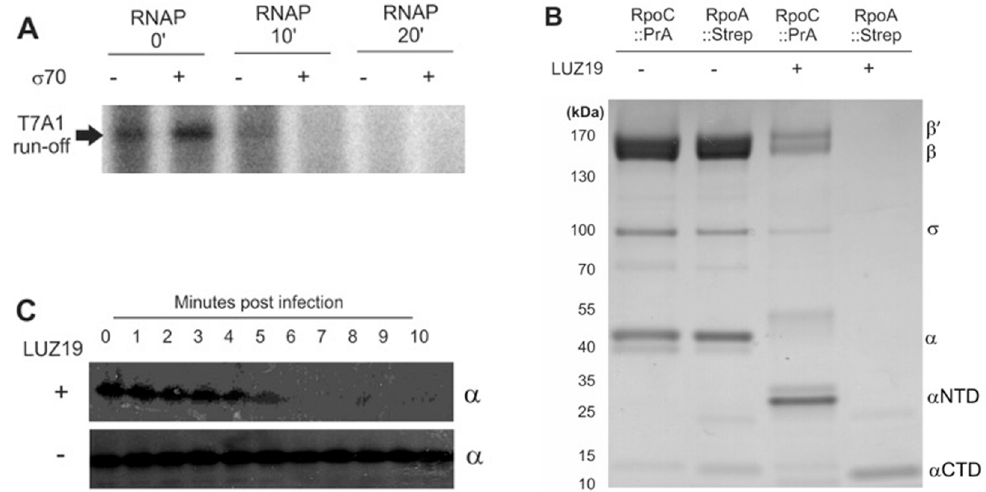
Figure 1. The bacterial DNA-dependent RNA polymerase (RNAP) complex is cleaved and inactivated during phage infection. ( A ) In vitro transcription by the P. aeruginosa RNAP complex isolated before and during LUZ19 infection. ( B ) Pull-down analyses of the P. aeruginosa RNAP complex after 10 min of phage infection. Purification were mediated by Protein A or Strep affinity tags fused to the C-terminus of the β ’ (RpoC) and α (RpoA) subunits. Eluates were separated on a 4–15% SDS-PAGE gel. ( C ) Western blot analysis of bacterial cell lysates collected at indicated times post infection. We collected phage-infected bacterial cells with single-minute intervals between one and ten minutes post infection, and compared to the uninfected sample (time point 0). Equal amounts of the soluble protein fraction of these samples were subjected to Western Blot using an antibody specific for the α RNAP subunit. N/C-terminal domain (NTD, CTD).